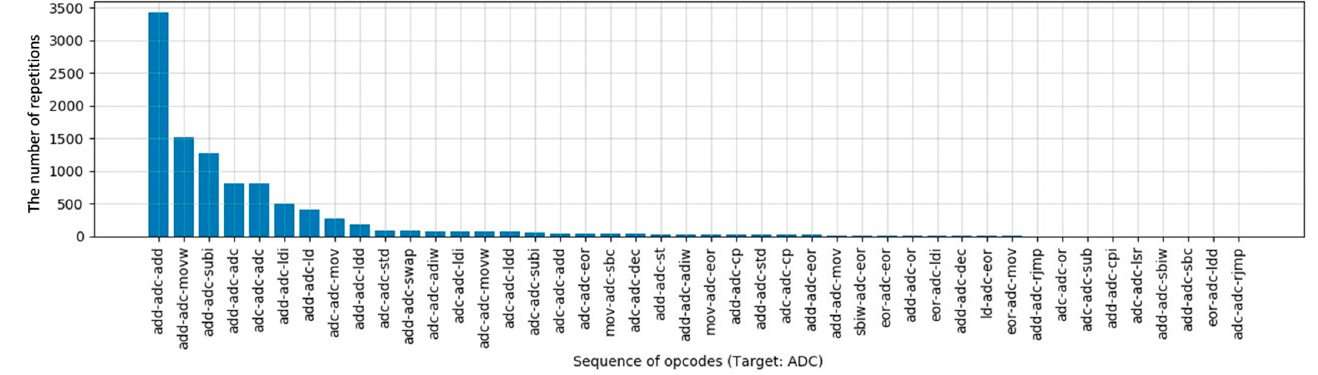
Figure 5. The result of instruction sequence analysis (ADC of the ATxmega128).